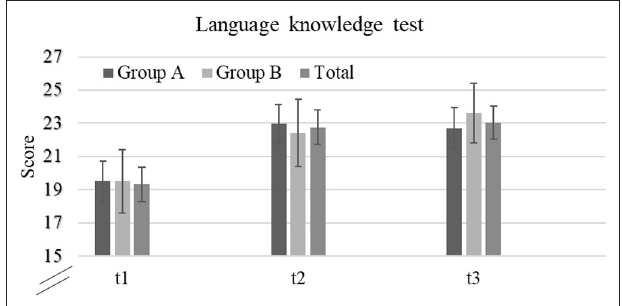
FIGURE 2 | Performance language knowledge test (max. 32): means and standard deviations for both groups at the three time points.